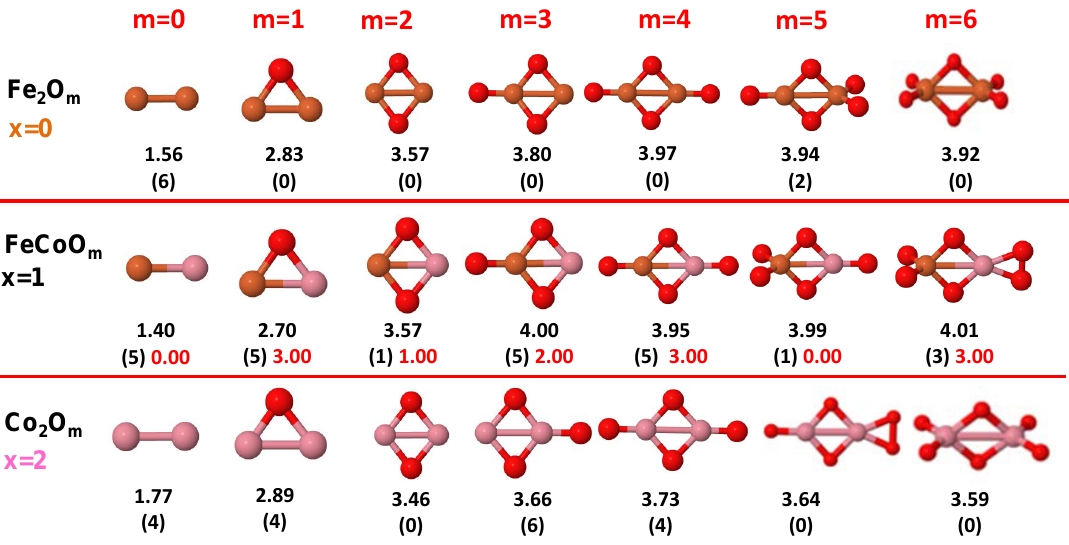
Figure 1. Putative global minimum structures of Fe 2 − x Co x O m , x = 0–2, m = 1–6. Numbers below structures are the binding energy per atom (in eV), numbers in parentheses are the magnetic moment (in µ B ) and the third number (when present) is the excess magnetic moment (in µ B ) defined in Equation (2). Fe atoms in brown color, Co atoms in pink and oxygen atoms in red.